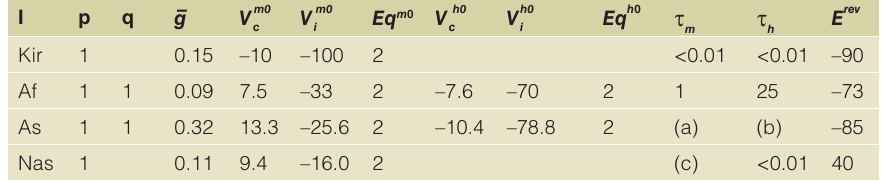
= 131.4/(exp(–( V + 37.4) /27.3) + exp(( V m m